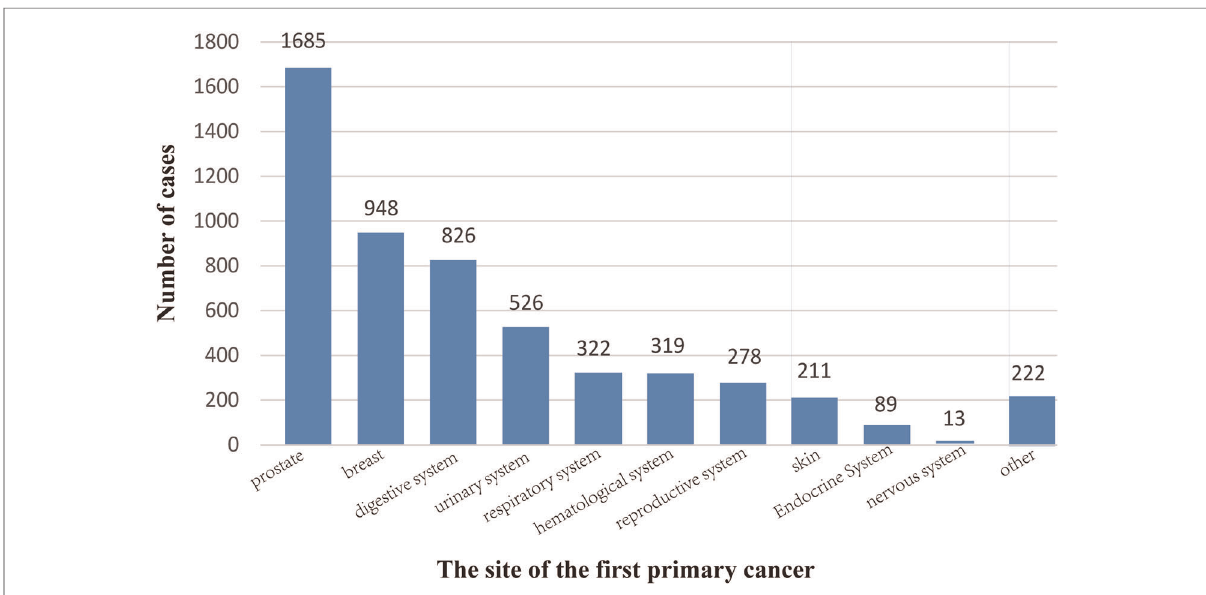
FIGURE 2 Location of the fi rst primary cancer. We divided it into 11 sites, the most common of which is the prostate (1685), followed by the breast (948) and the digestive system (826). The locations of 5,439 cases are shown here.